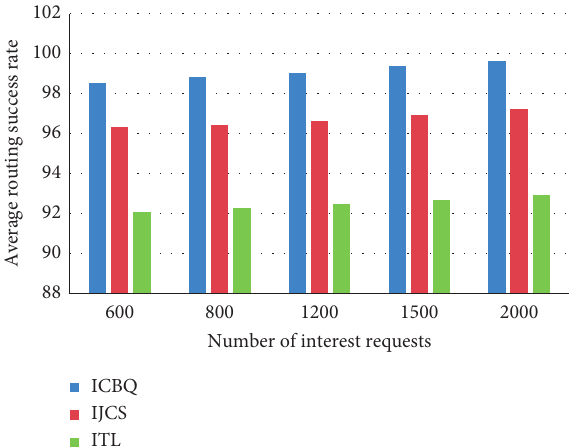
Figure 2: The average routing success rate (%) among ICBQ, IJCS, and